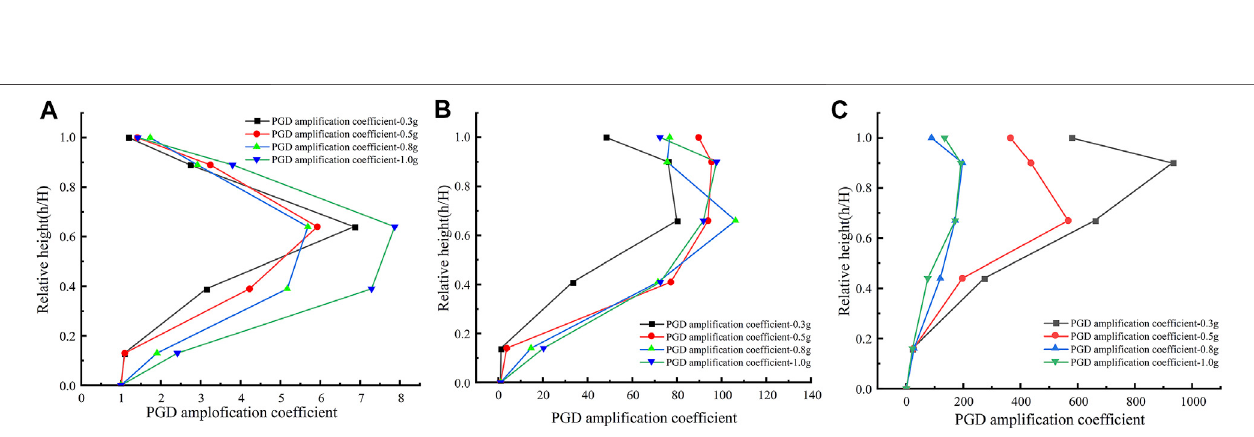
FIGURE 10 | Variation of PGD ampli fi cation coef fi cient with relative height (A) weak interlayers dip is 15 ° , (B) weak interlayers dip is 30 ° , (C) weak interlayers dip is 45 ° .